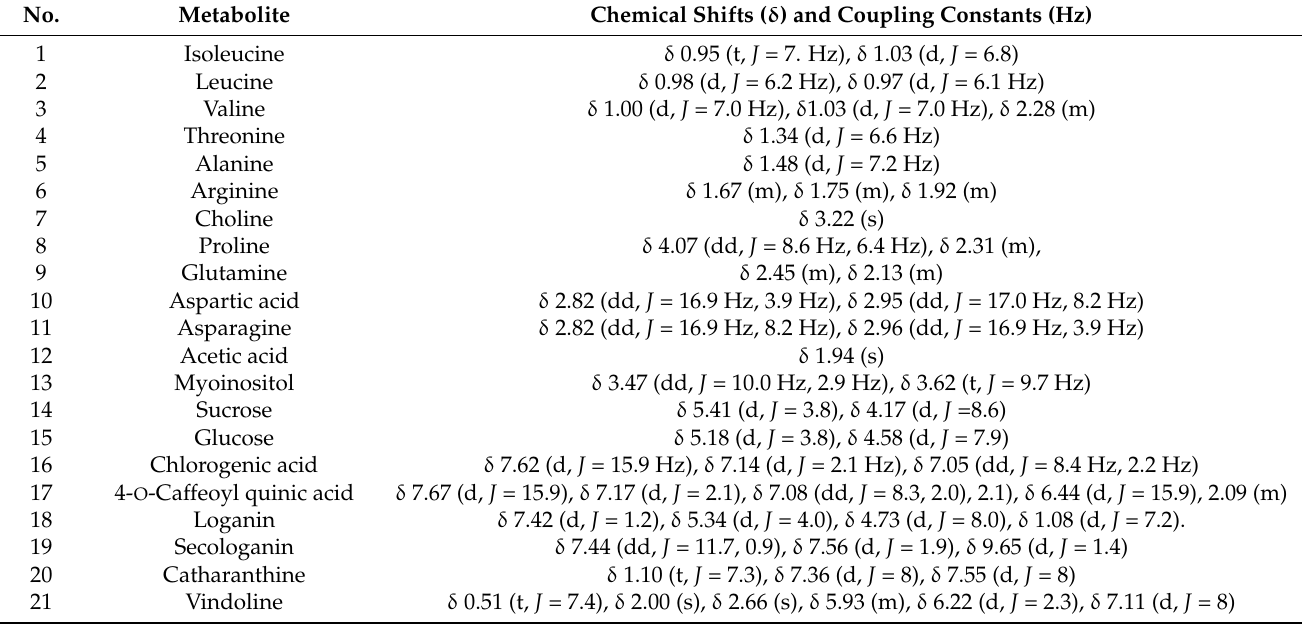
Table 1. 1 H chemical shifts ( δ ) and coupling constants (Hz) of Catharanthus roseus seedlings metabo- lites in methanol-d 4 -KH 2 PO 4 in D 2 O at pH